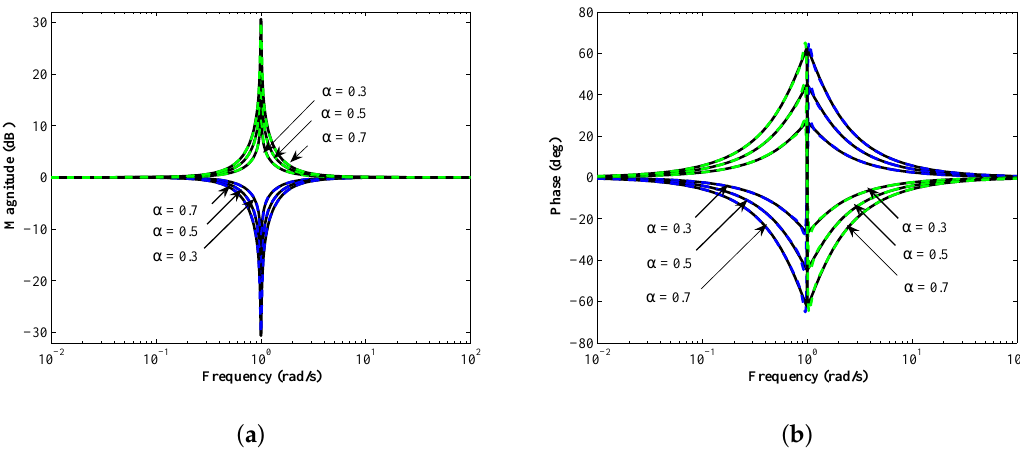
Figure 6. ( a ) Magnitude and ( b ) phase–frequency responses of the proposed BSPLFs (dashed blue) and IBSPLFs (dashed green) as compared to the theoretical ones (solid